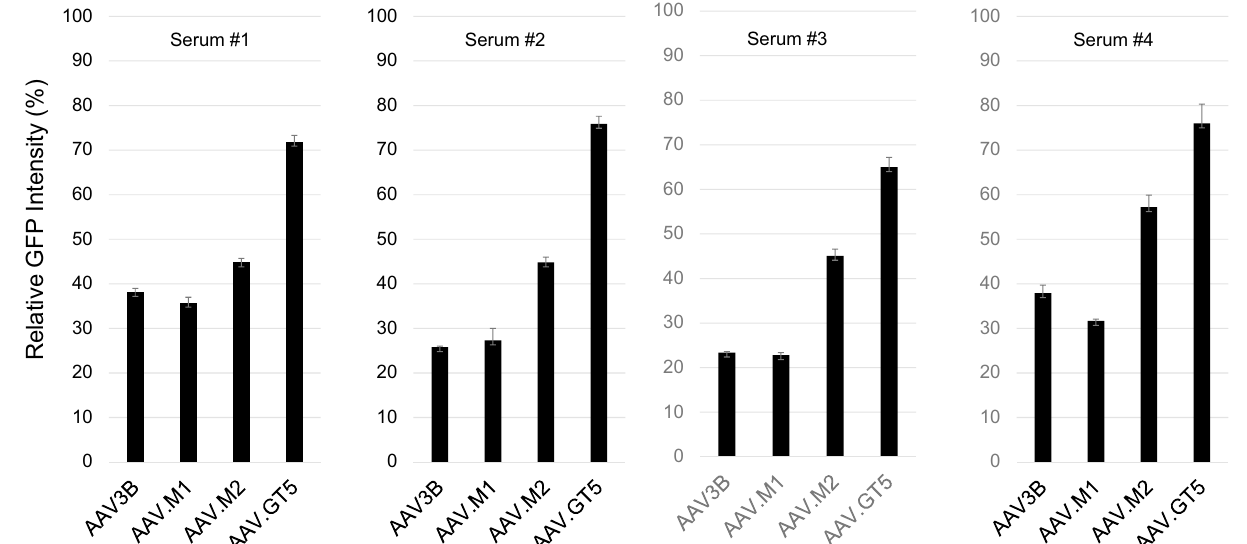
Figure 6. Comparison of NAb inhibitory effects on transduction efficiency. In four serum samples that reduced transduction of AAV2 vectors by more than 50% at 1:32 dilution, transduction was less inhibited in AAV.GT5 vectors than in AAV3B, AAV.M1, or AAV.M2 vectors, suggesting these sera had lowest cross-reactivity against AAV.GT5 vectors. On the vertical axis, the intensity of GFP in the control, which was not mixed with serum containing the NAbs, was set to 100%. Relative GFP intensities were measured in four wells for each